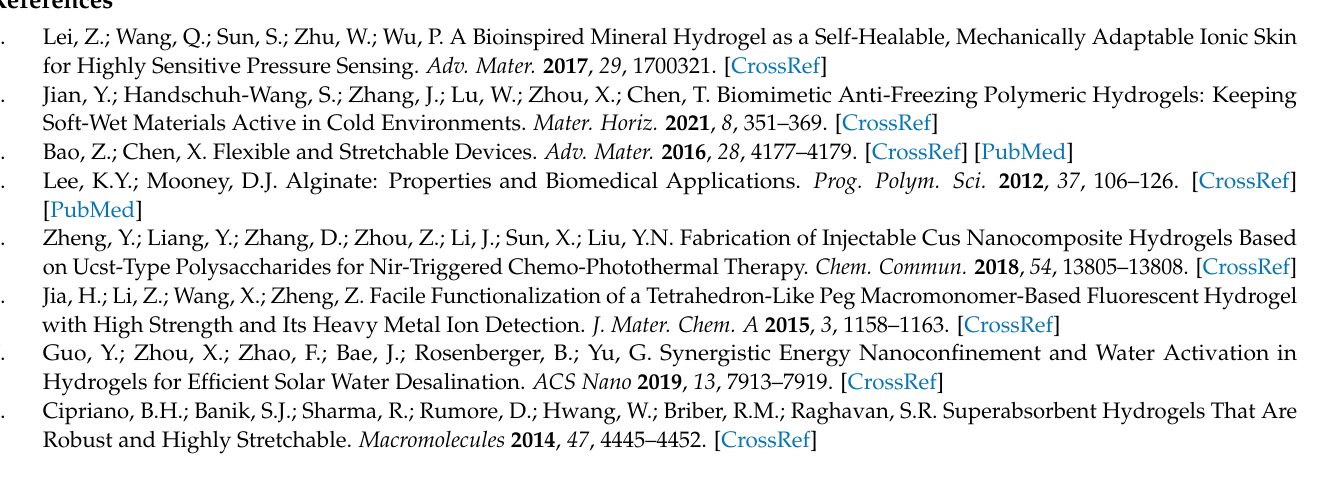
hydrogels, Figure S4: relationship between the freezing points and the glycerol mass ratio in mixed solutions, Figure S5: comparison of the freshly prepared hydrogels and hydrogels after a storage time of 15 days, Figure S6: tensile stress and modulus of hydrogels, Figure S7: circuits comprised of the hydrogel and a green LED light, Table S1: compositions of the HAPAA hydrogel and HAG x hydrogels, Table S2: comparison of the HAG 11 hydrogel with other antifreeze stretchable hydrogels in mechanical strength, Table S3: Interaction energies in H 2 O-HAPAA, glycerol-HAPAA, and